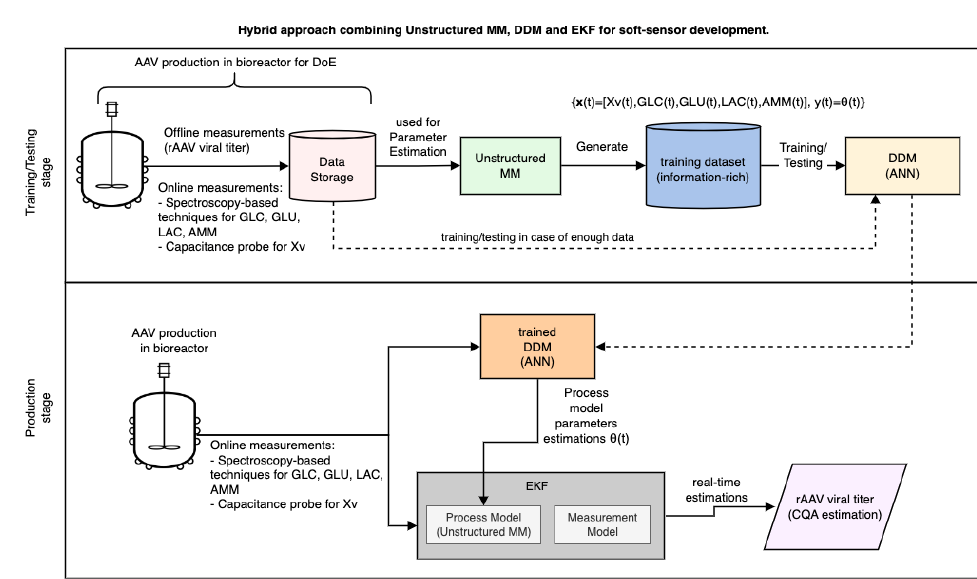
Figure 2. Soft sensor development approach based on HM for rAAV production monitoring. A possible approach is combining unstructured MM, DDM and EKF for real-time monitoring of rAAV viral